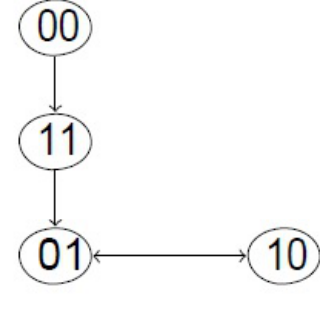
Fig. 1 Phase diagram of the